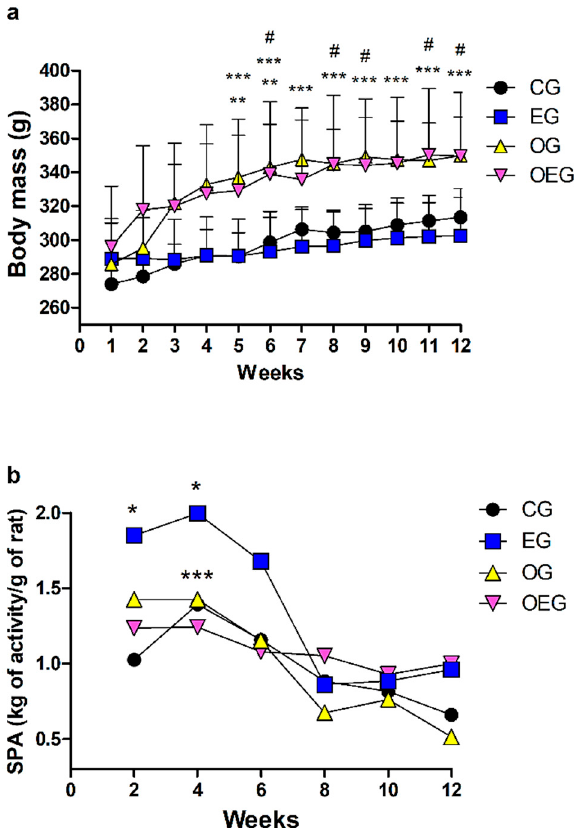
Figure 4. Data from body mass ( a ) and spontaneous physical activity ( b ) throughout 12 weeks of experiment in the control group (CG; n = 10), ovariectomized group (OG; n = 10), exercised group (EG; n = 9) and ovariectomized and exercised group (OEG; n = 9). Values expressed as mean and standard deviation for body mass and as sum of the day for spontaneous physical activity. The statistics provided in the graphs are the results of the Newman–Keuls post hoc test: * p < 0.05 EG in relation to CG within same week; ** p < 0.05 OG in relation to CG within same week; *** p < 0.05 OG in relation to EG within same week; # p < 0.05 OEG in relation to EG within same week. SPA: spontaneous physical activity; kg: kilograms; g: grams.